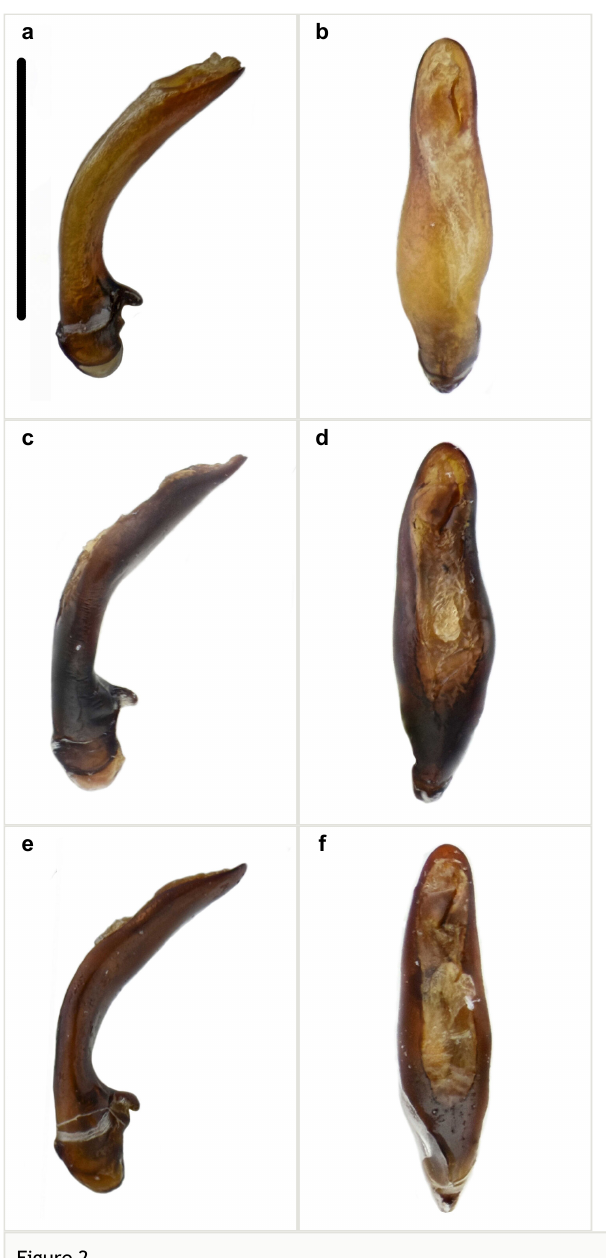
Left lateral view and dorsal view of median lobe of aedeagus of Pareuryaptus spp. from China (scale bar = 2 mm): a & b , P. exiguus Dubault, Lassalle & Roux, Naqin Village, Guangxi; c & d , P. luangphabangensis Kirschenhofer, Nanpaxiaozhai, Yunnan; e & f , P. chalceolus chalceolus (Bates), Guanyin Mt.,